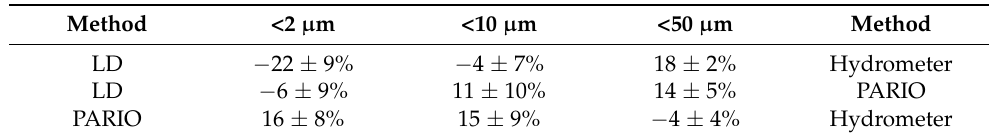
Table 1. Comparison of average differences of representation of particles smaller than 2, 10 and 50 µ m between three tested methods ( ± SD), differences between the results for methods in the first and the last